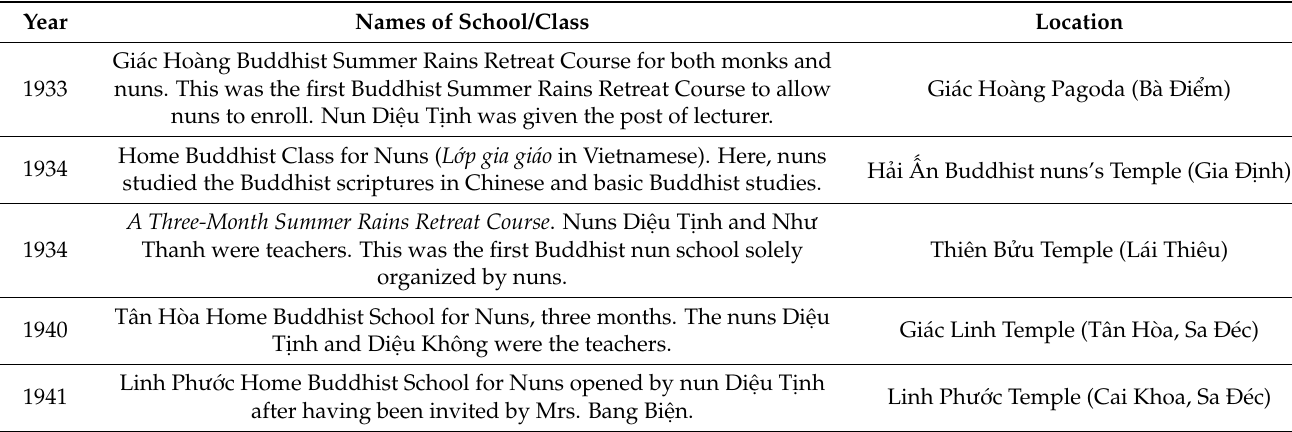
Table 3. A list of Buddhist schools attended by